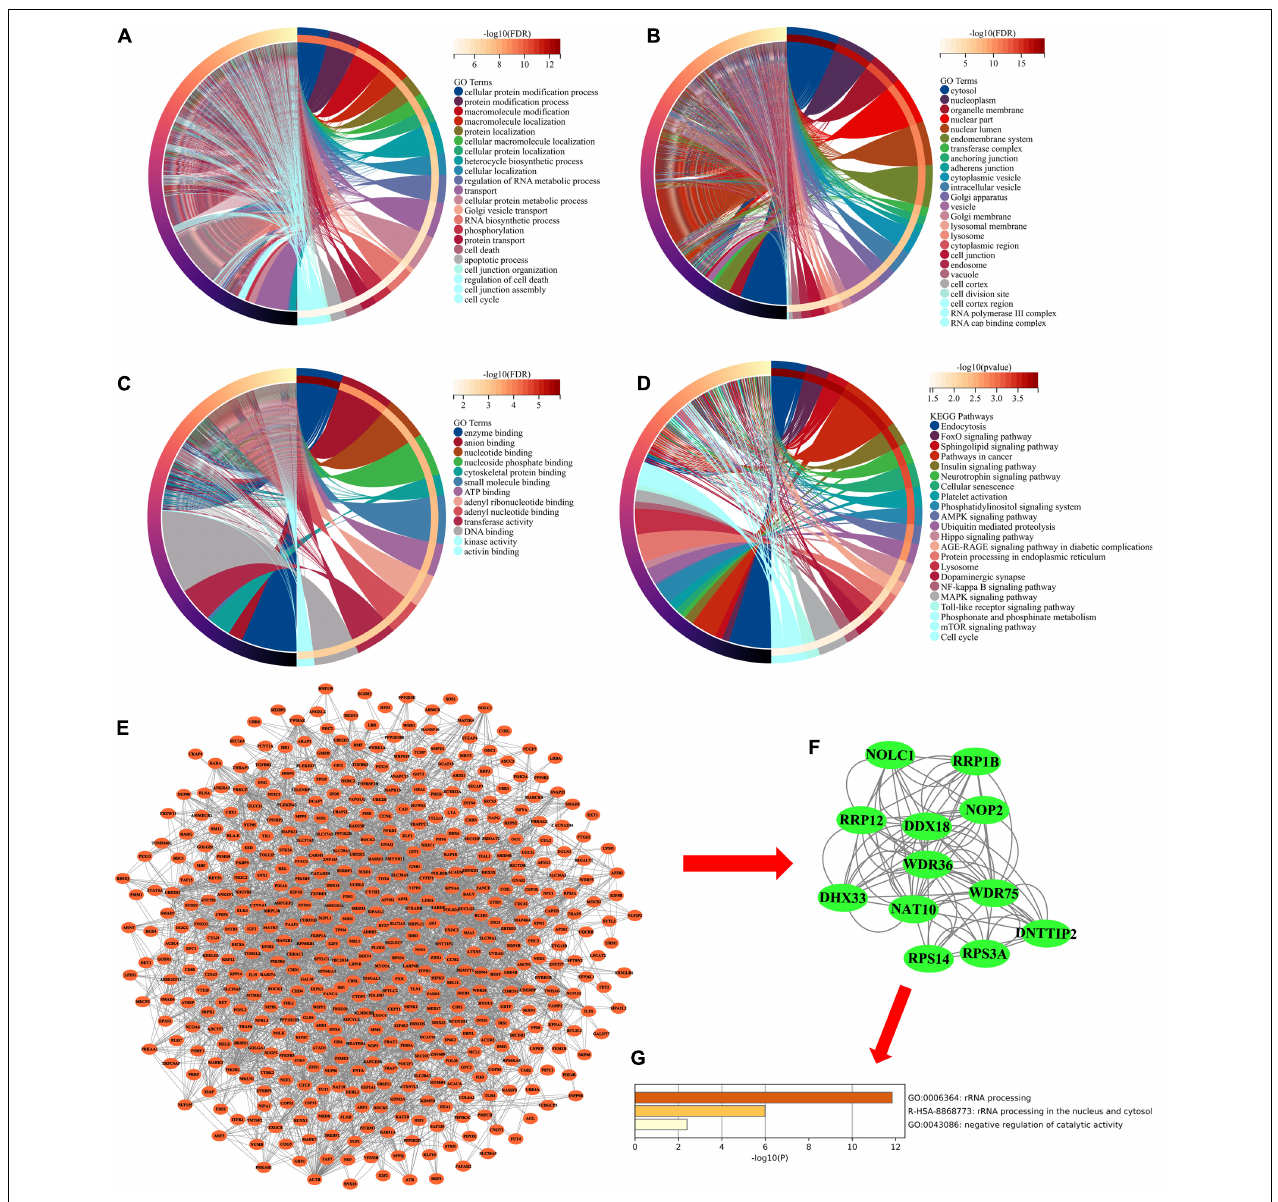
FIGURE 4 | (A) Chord diagram showing enriched GO-BP clusters for the mRNAs in miRNA-mRNA regulatory network. BP, biological processes. (B) Chord diagram showing enriched GO-CC clusters for the mRNAs in miRNA-mRNA regulatory network. CC, cell composition. (C) Chord diagram showing enriched GO-MF clusters for the mRNAs in miRNA-mRNA regulatory network. MF, molecular functions. (D) Chord diagram showing enriched KEGG clusters for the mRNAs in miRNA-mRNA regulatory network. GO, Gene Ontology; KEGG, Kyoto Encyclopedia of Genes and Genomes. (E) PPI network analysis for the mRNAs in miRNA-mRNA regulatory network. PPI, protein–protein interaction. (F) The hub subnetwork from PPI network by Molecular Complex Detection (MCODE) plug-in. (G) Functional enrichment analysis of mRNAs in hub